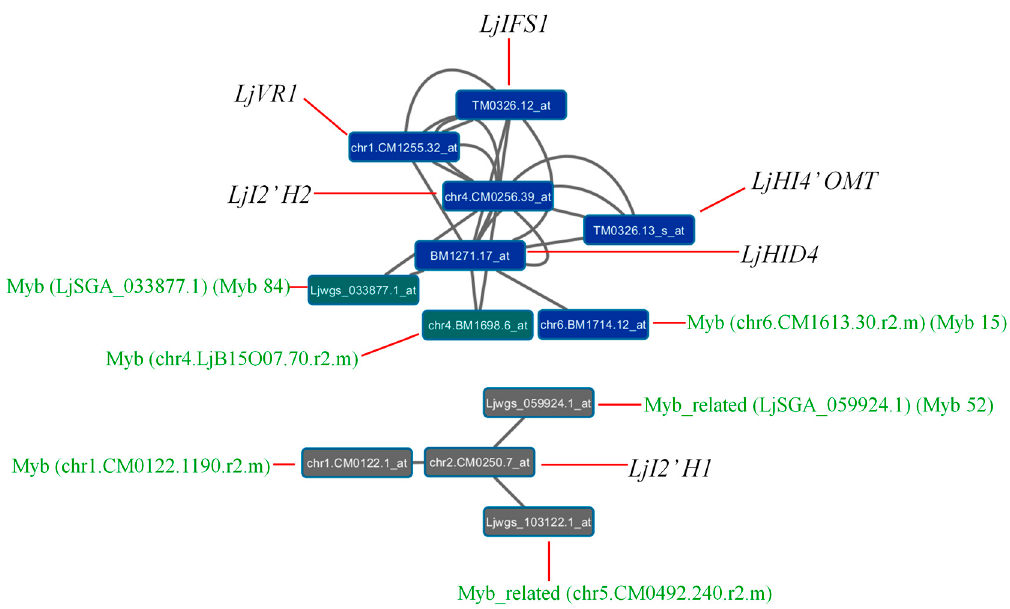
Figure 3. Gene co-expression network developed to analyze the connectivity between isoflavonoid biosynthetic pathway and MYB genes. Genes shown with the same color show a similar transcriptional regulation in all data analyzed. Grey lines indicate the interconnections between isoflavonoid and MYB genes, and red lines link probesets with gene names or Kazusa codes of genes. The co-expression network was visualized using Cytoscape and analyzed using the NetworkAnalyzer [135]. Gene abbreviations as described in Figure 1 and other codes as reported in Kazusa 2.5 terminology. Gene codes according to the 3.0 version of the L. japonicus genome are: LjIFS1 (Lj4g3v0485090.1); LjI2’H1 (Lj2g3v1925730.1); LjI2’H2 (Lj4g3v0189840.1); LjHID4 (Lj5g3v2057520.1);